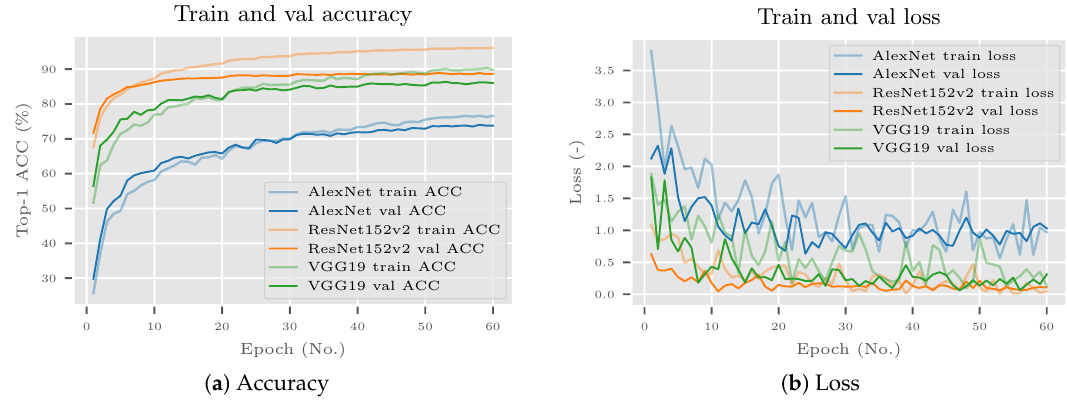
Figure 12. Accuracy ( a ) and loss ( b ) graphs of training and validating CNNs on VireoFood-172 subset. All graphs show relatively well-trained CNNs. The algorithms did not overfit, and additional training would not significantly improve the